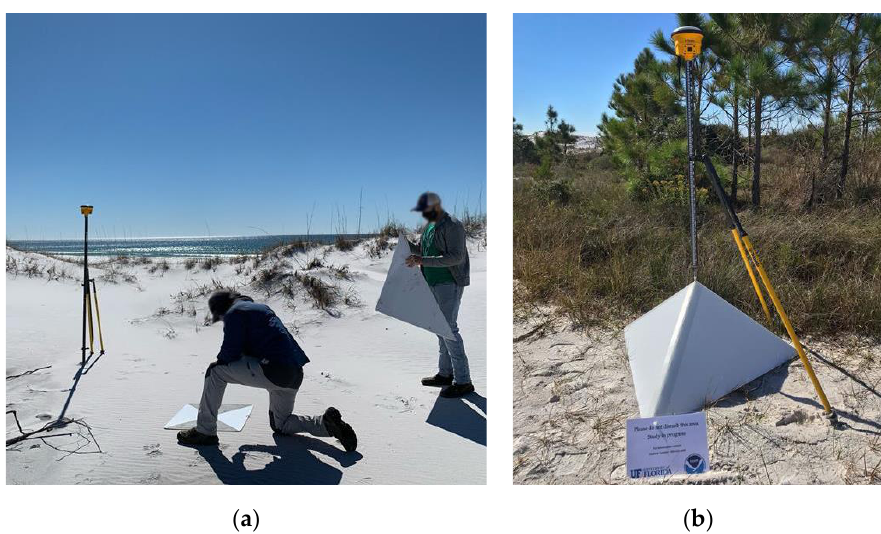
Figure 3. ( a ) Setting up a pair of ground control targets. Targets were placed in open, predominately flat terrain. ( b ) Data collection over the pyramidal target. GNSS measurements were taken at the top of the pyramid.